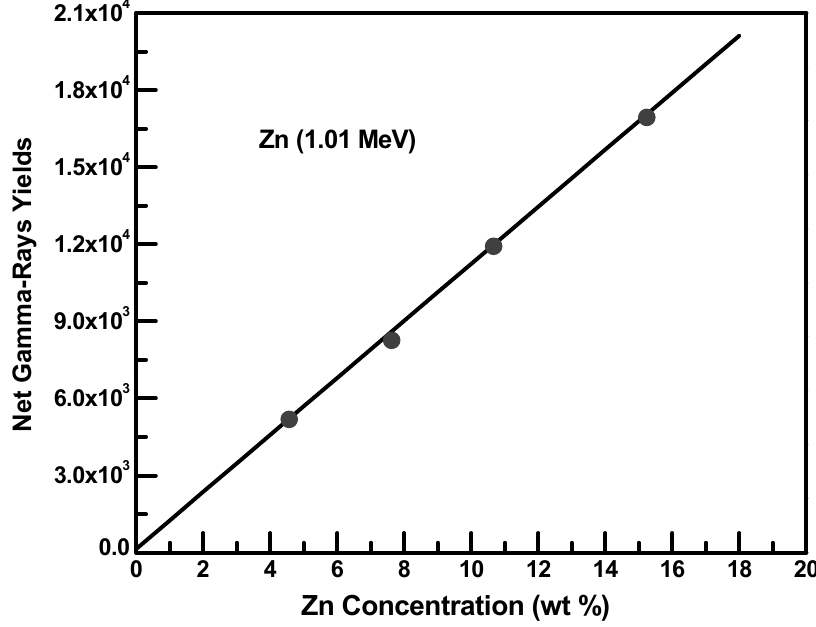
Figure 7. The yields of titanium prompt gamma-ray at 0.984 MeV as a function of its concentration in soil samples. The solid line represents the best fit for the data using the inverse variance weighting scheme.